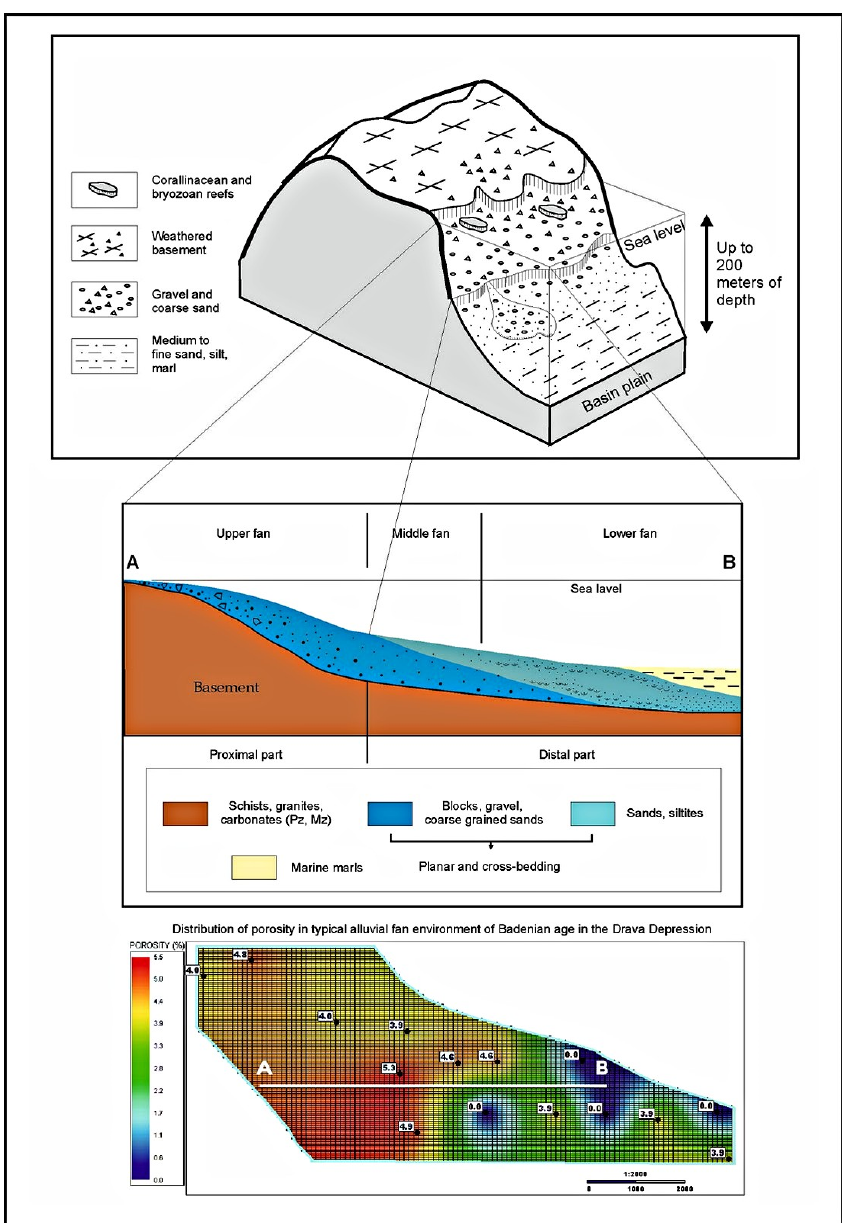
Figure 9. A typical Early Badenian depositional environment, with clinoform structures, recon- structed by [80], based upon the data from the Drava Depression (Stari Gradac Structure).